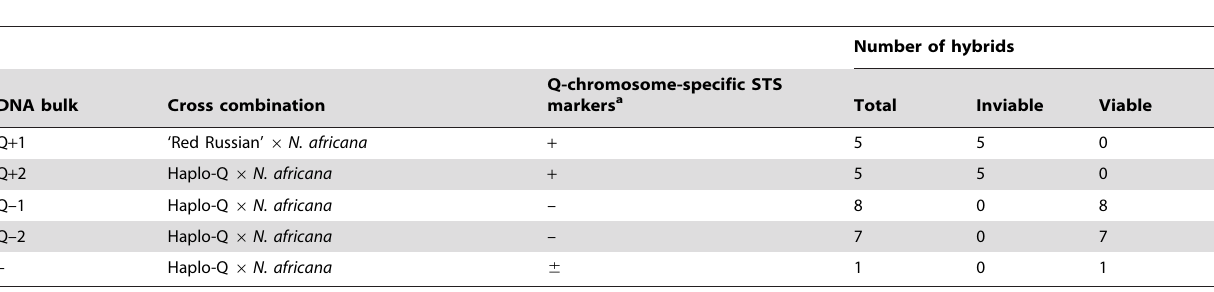
Table 1. Two types of DNA bulks prepared from DNA of hybrids from crosses N. tabacum 6 N. africana .